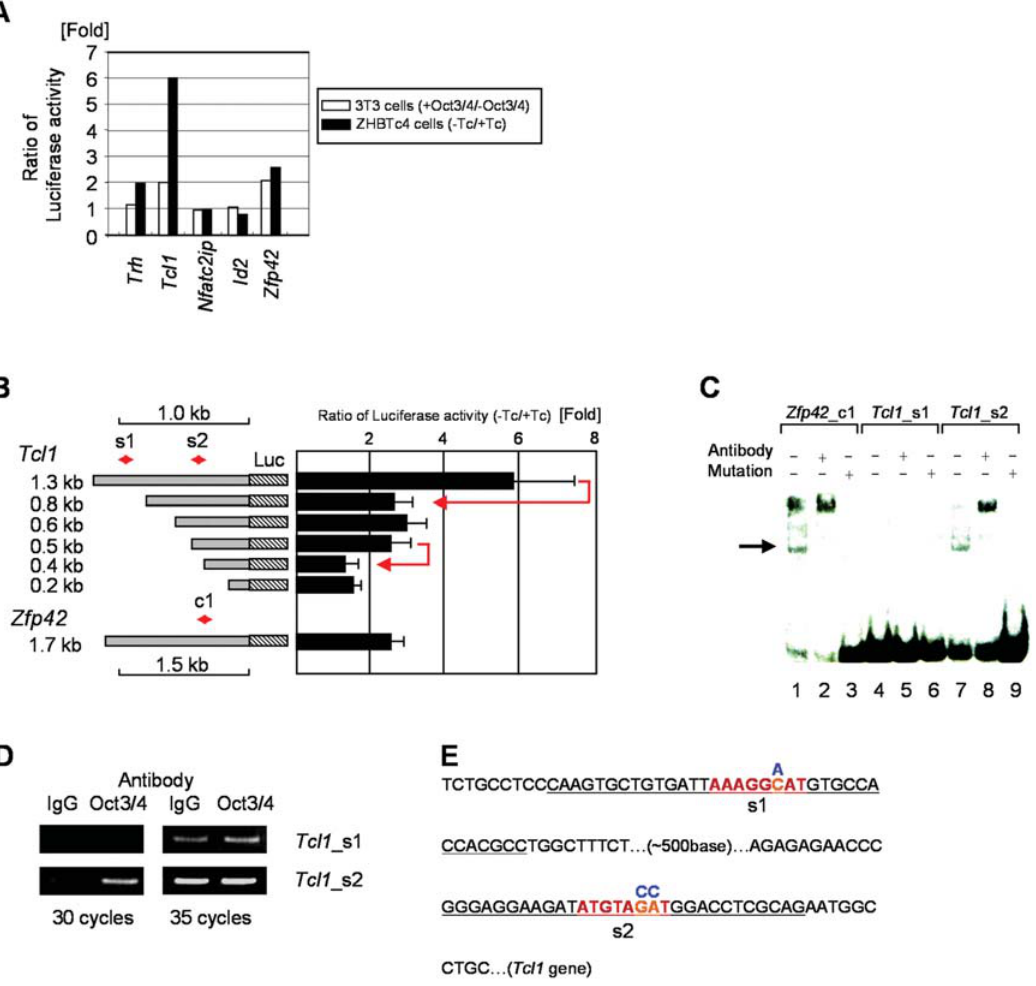
Figure 5. Tcl1is regulated by Oct3/4 . (A) Luciferase assay for 4 candidate Oct3/4 target genes and one known target gene ( Zfp42 ). (B) Luciferase assay for deletion analysis of region upstream of Tcl1 gene. s1 and s2 are candidates for Oct3/4 binding sites, with sequence shown in (E). (C) EMSA for two candidate sites. The arrow indicates the band for Oct3/4/oligonucleotide binding. (D) ChIP assay of two target sites (see Experimental Procedures). (E) The sequence around s1 and s2 sites and the position of mutations for EMSA oligos (blue nucleotides).